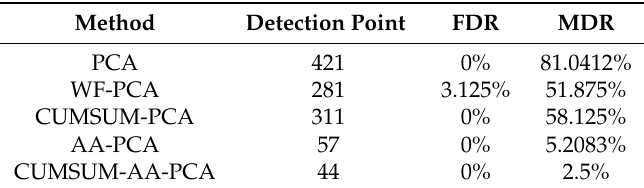
Table 1. Detection result of SPE chart for